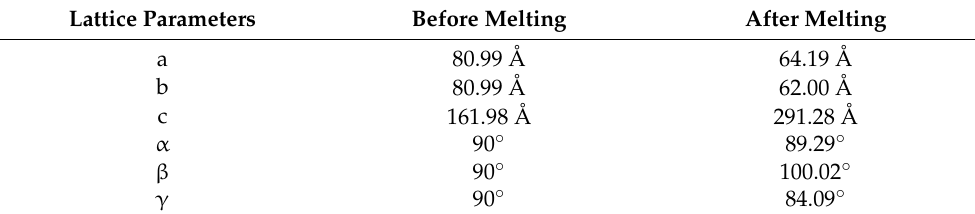
Table 1. Lattice parameters of the Al (s) -Al (l) coexistence model before and after melting. Lattice Parameters Before